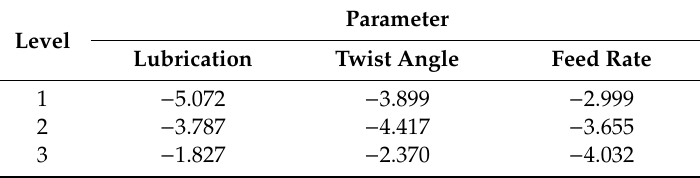
Figure 8. Main e ff ects plot for the signal to noise (S / N) ratios. Table 5. Main response table of the grey relational grade